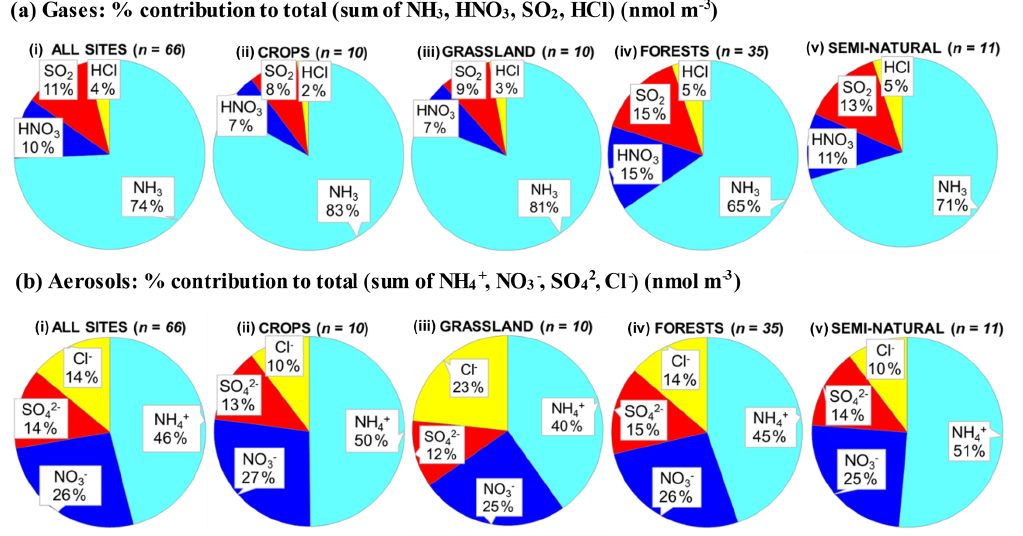
Figure 12. Pie charts of mean relative proportions of (a) gases (NH 3 , HNO 3 , SO 2 , HCl) and (b) aerosols (NH + are annual averaged concentrations (nmol m − 3 ) measured at NEU DELTA ® sites for (i) all sites ( n = 66) and sites grouped according to ecosystem types, (ii) crops ( n = 10), (iii) grassland ( n = 10), (iv) forests ( n = 35), and (v) semi-natural ( n = 11). UK-AMoP (parallel DELTA ® at Auchencorth: NH 3 and NH +